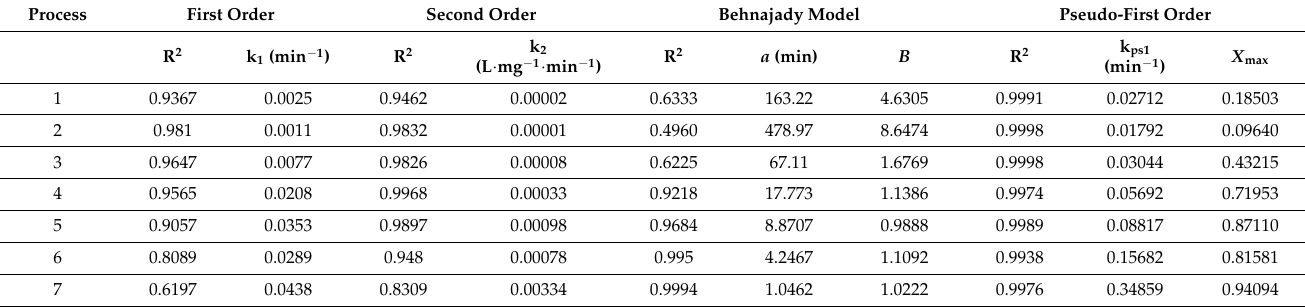
Figure 5. Kinetics plots of the four studied kinetic models ( a ) first order; ( b ) second order; ( c ) Behnajady model; ( d ) pseudo-first order model. Table 1. Parameters of the studied kinetic models for the degradation of Acid Brown 83 by seven processes ((1: US; 2: H 2 O 2 ; 3: US/ H 2 O 2 ; 4: H 2 O 2 /H 2 SO 4 ; 5: US/H 2 O 2 /H 2 SO 4 ; 6: Fe(II)/H 2 O 2 /H 2 SO 4 ; 7: US/ H 2 O 2 /H 2 SO 4 ). Process